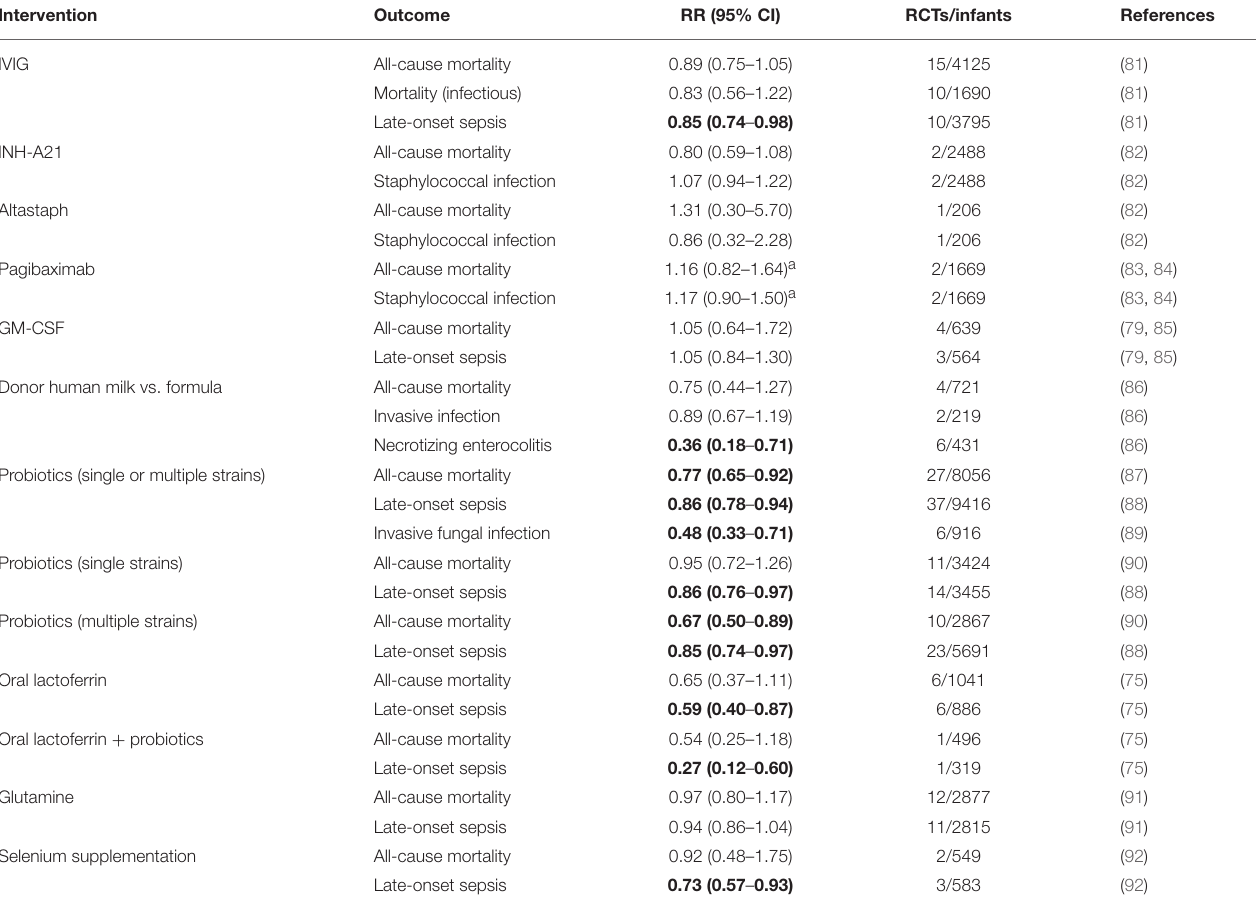
TABLE 2 | Meta-analyses on preventive strategies for sepsis in preterm infants.